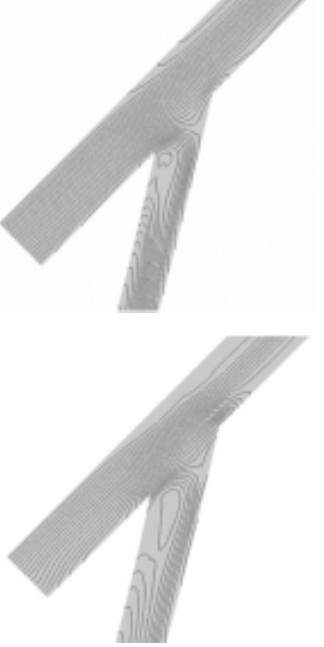
Fig. 9 - Behavior of the flow in the graft and pulmonary artery according to the diameter of the PTFE graft. Note that the recirculation region in the graft increases as the diameter of the graft increases note that the pressure increases as the diameter of the graft reduces. Nevertheless, the position of the maximum pressure in the graft does not change as the diameter changes.